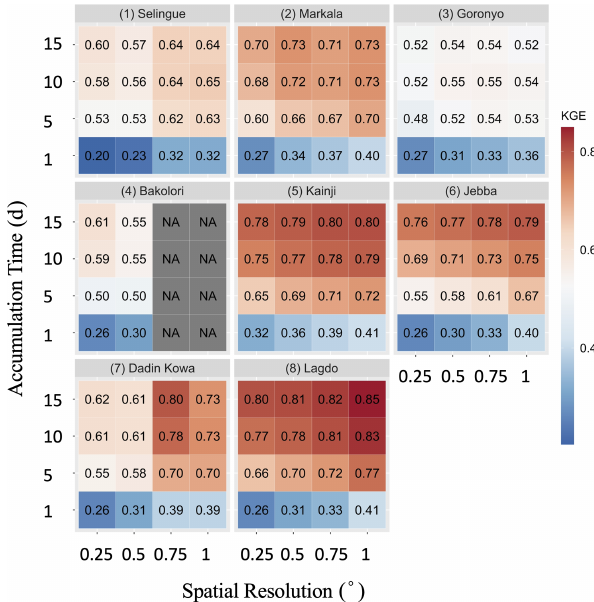
Figure 10. Kling–Gupta efficiency (KGE) of GFS as a function of the accumulation timescale (1, 5, 10, and 15d) and spatial scale (0.25, 0.50, 0.75, and 1.0 ◦